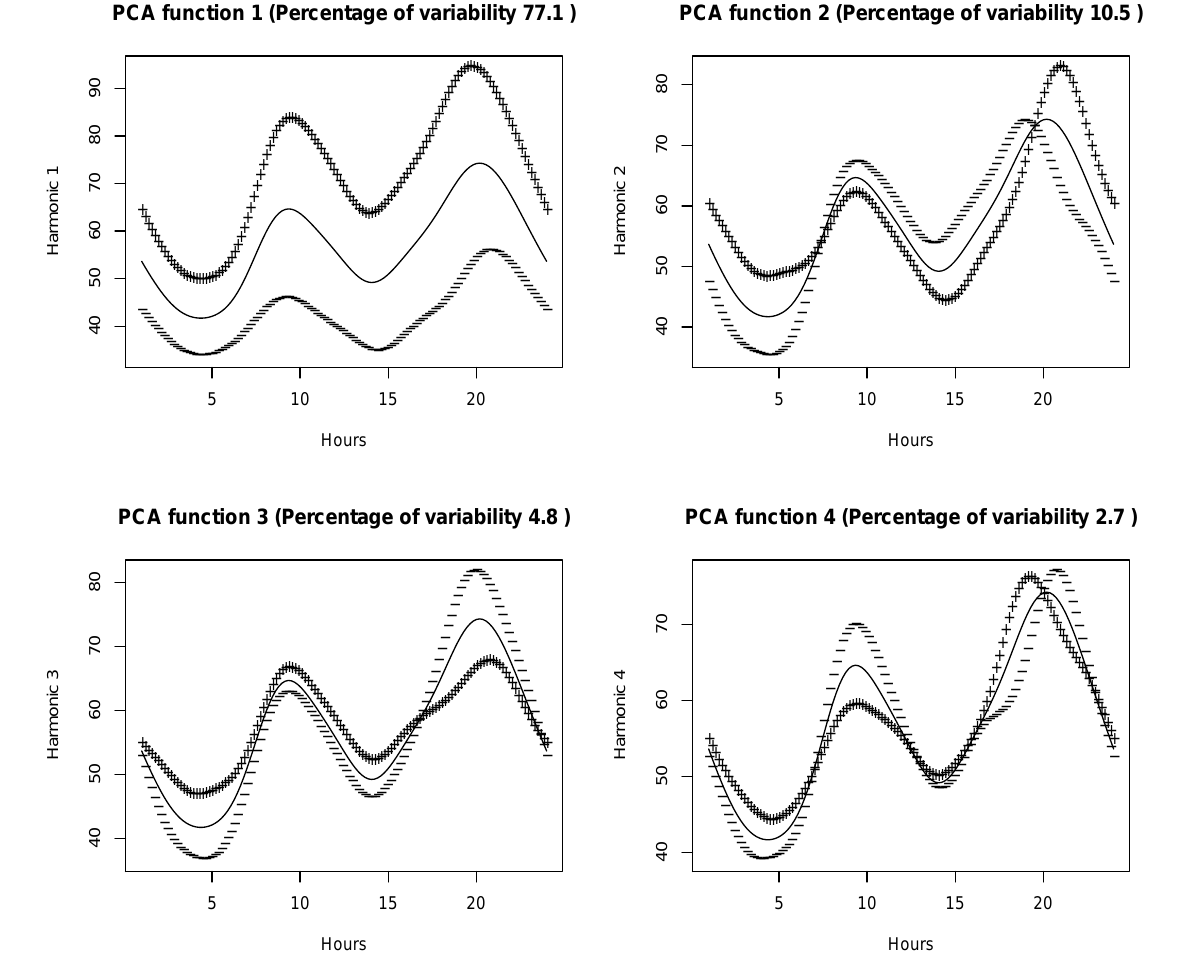
Figure 3. The effect of 1st FPC ( upper lef t panel), the effect of 2nd FPC ( upper rig ht panel), the effect of 3rd FPC ( lower left panel), and the effect of 4th FPC ( lower right